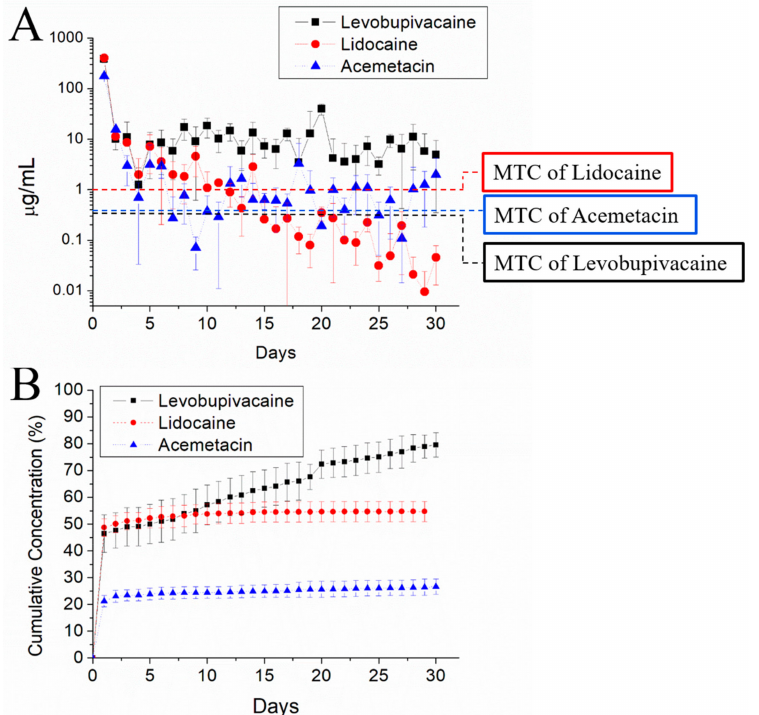
Figure 5. Release curves of analgesics from the electrosprayed microparticles during incubation in vitro. ( A ) Daily releases of levobupivacaine (black squares), lidocaine (red circles), and acemetacin (blue triangles). The dashed lines indicate the minimum therapeutic concentration (MTC) for each analgesic. ( B ) Cumulative values over the 30-day